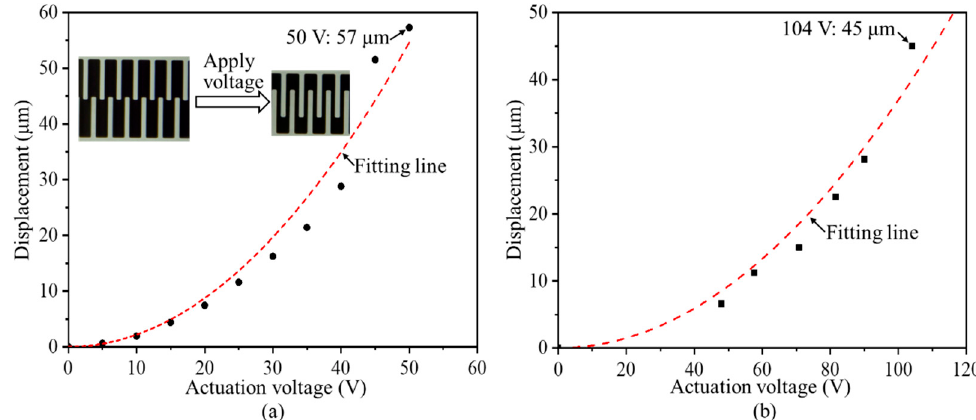
Figure 5. Optical measurement results of the displacements versus actuation voltages of the comb- drive actuators: ( a ) With small spring constant; ( b ) with large spring constant of support springs. (The inset shows the captured motions of the comb fingers at different actuation voltages using a digital microscope.).